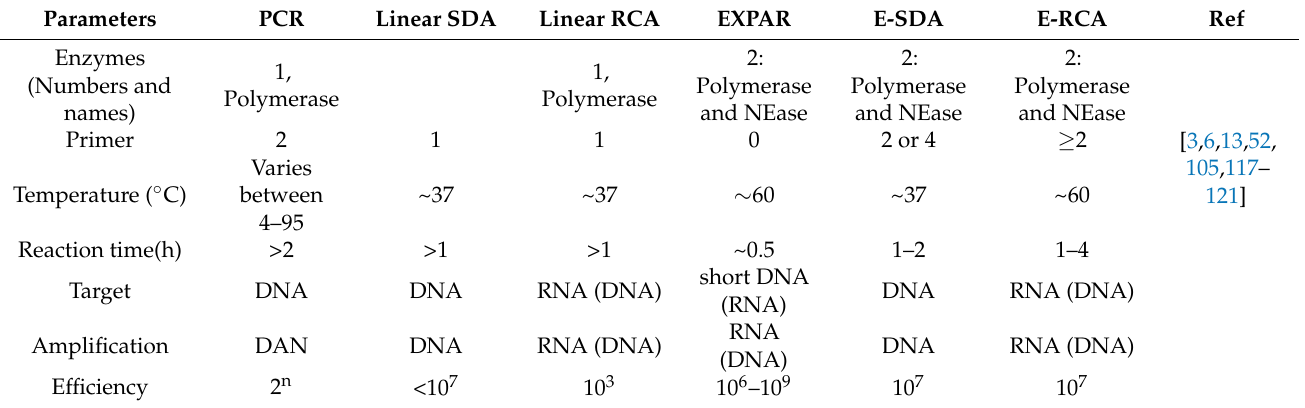
Table 2. Comparison of various isothermal